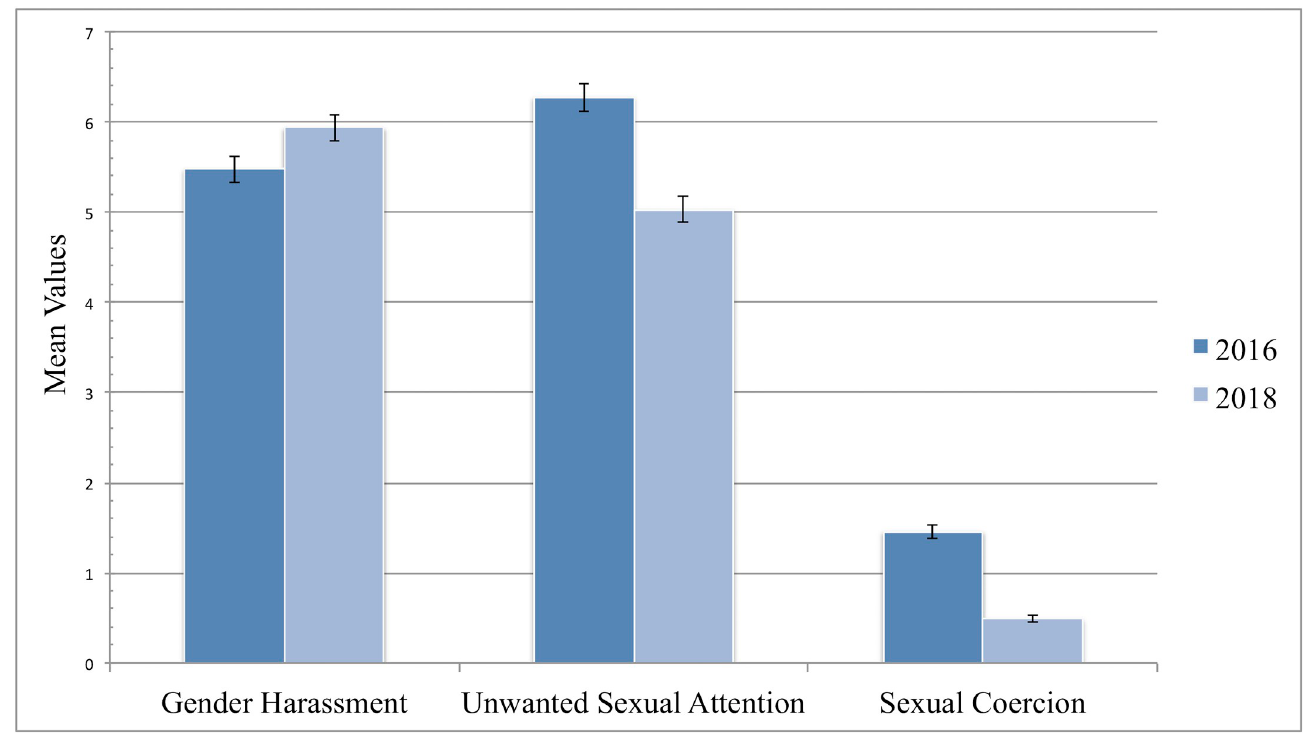
Fig 1. Coefficient estimates for the relationship between year and sexual harassment (sexual coercion, unwanted sexual attention, gender harassment) in 2016 and 2018. Estimates are derived from a Generalized Linear Model using a Poisson distribution of 507 women, 250 of whom were surveys in September 2016 and the remaining women were surveyed in September 2018. We controlled for race (White/non-White), position level, and work experience. Sexual coercion and unwanted sexual attention significantly decrease whereas gender harassment significantly increased over this year.